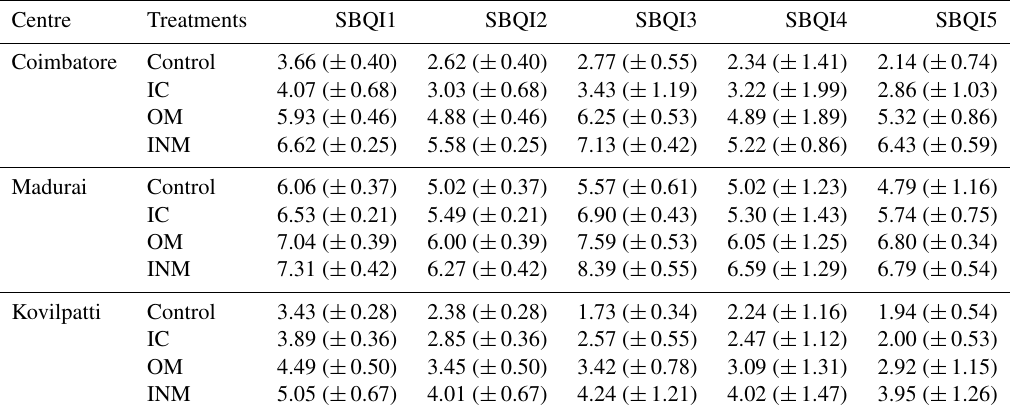
Values are the mean ( ± SD) of three replicates. Control – unfertilized control soil; IC – inorganic chemical fertilized soil; OM – organically managed soil; INM – integrated nutrient management enforced soil; SBQI1–SBQI5 refer to the unitless 10-scaled soil biological quality index computed using six soil biological variables.